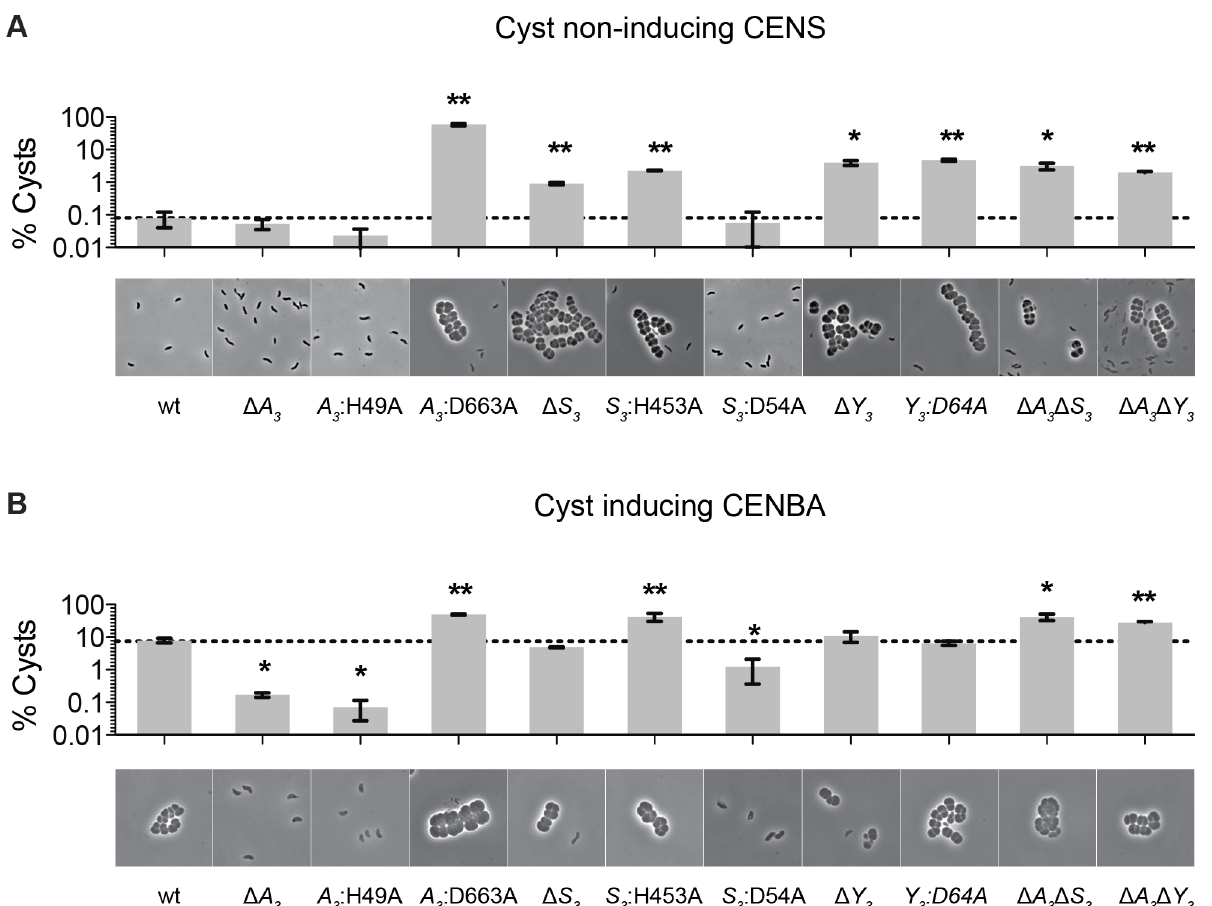
Figure 2. Characterization of cheS 3 , cheA 3 and cheY 3 mutants. The encystment phenotypes of 11 strains including wild type and single, double, and point mutants of cheS 3 , cheA 3 and cheY 3 were measured qualitatively by phase contrast microscopy and quantitatively by flow cytometry. (A) Growth on nutrient-rich CENS medium reveals hyper-cyst strains that overproduce cysts relative to wild type. (B) Growth on nutrient- limiting CENBA medium identifies hypo-cyst strains that under-produce cyst cells relative to wild type. Error bars in the bar graphs represent standard deviation obtained from two biological replicates. * (p , 0.05), ** (p , 0.01) when compared to the wild type (wt) strain in an unpaired t -test.